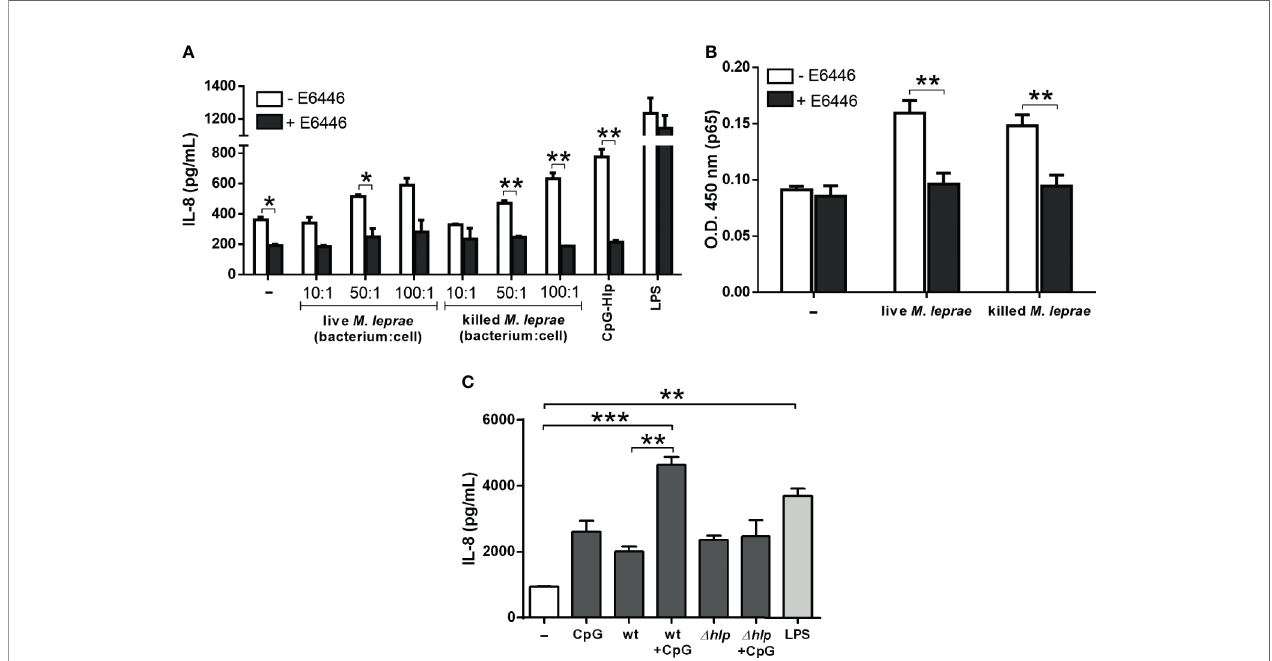
FIGURE 5 | M. leprae induces the secretion of IL-8 in human alveolar epithelial cells via TLR-9/NF- k B signaling. Quanti fi cation of IL-8 levels in the culture supernatant (A, C) and assessment of the relative levels of p65 subunit in the nuclear extracts (B) of A549 cells through ELISA. (A) Cells were pretreated with the TLR-9 antagonist E6446 and stimulated with live or killed M. leprae at different bacterium:cell ratios for 24 hours. CpG-Hlp complex and LPS were used as positive and negative controls, respectively. (B) Cells were pretreated with E6446 and stimulated with live or killed M. leprae at a bacterium:cell ratio of 50 for 30 minutes. (C) Cells were stimulated with M. smegmatis wt or D hlp preincubated or not with CpG at a bacterium:cell ratio of 10, or with CpG alone for 48 hours. LPS was used as a positive control. (A, B) Unpaired t -test with differences considered statistically signi fi cant between them. (C) ANOVA test with differences considered statistically signi fi cant between them after applying Bonferroni post-test. *p < 0.05; **p < 0.01; ***p < 0.001. Values represent the mean ± standard deviation of at least 3 independent experiments performed in